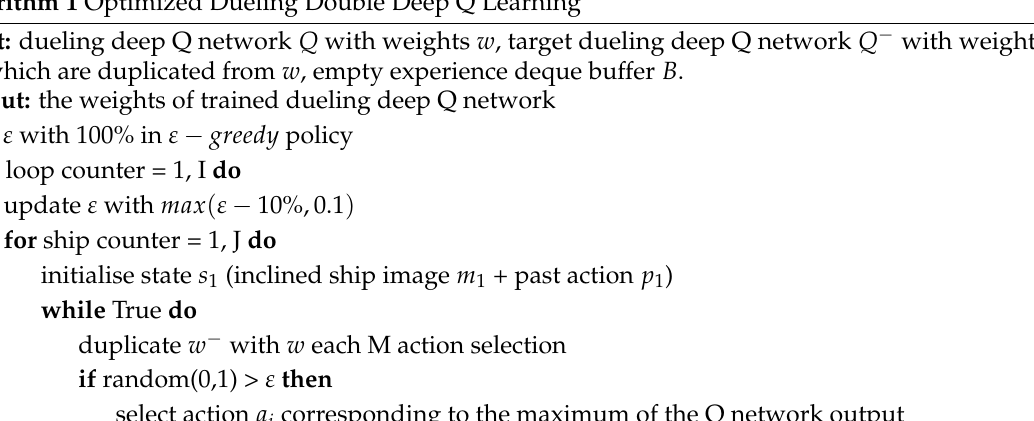
Algorithm 1 Optimized Dueling Double Deep Q